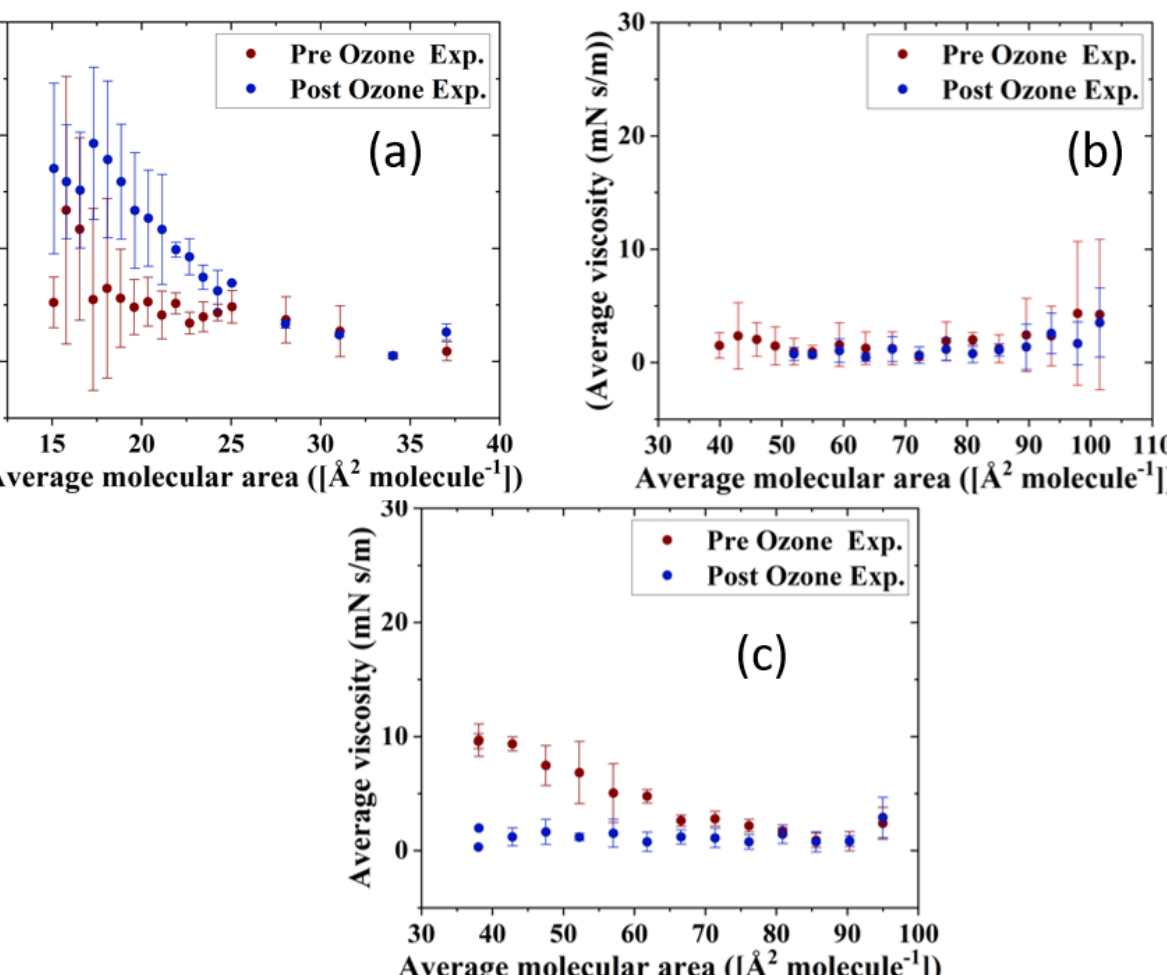
Figure 9. Surface dilational viscosity data of ( a ) CO:PC 90:10 (binary mixture); ( b ) CO:GT:PC 40:40:20 (ternary mixture); and ( c ) CO:GT:FFA:PC 40:25:15:20 (quaternary mixture) before ozone exposure (red) and after ozone exposure (blue) on PBS at 22 °C.